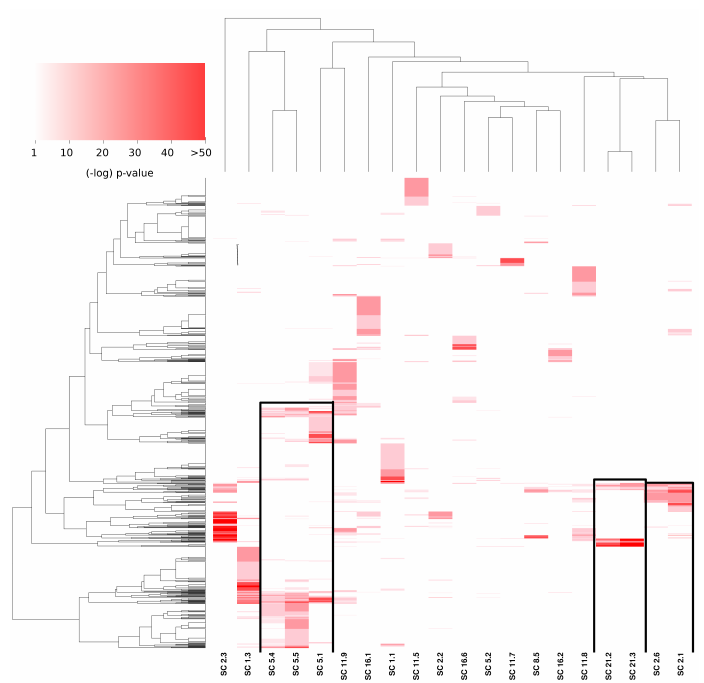
Figure 4. Over-represented communities in the PCN. This heat map shows those biological processes (Y axis) that are statistically associated with specific subcommunities (X axis). The intensity of color is proportional to the significance of the GO category in that subcommunity. Black squares highlight the subcommunities with a similar enrichment pattern. It is worth noticing that communities are mutually exclusive (there are no shared genes between